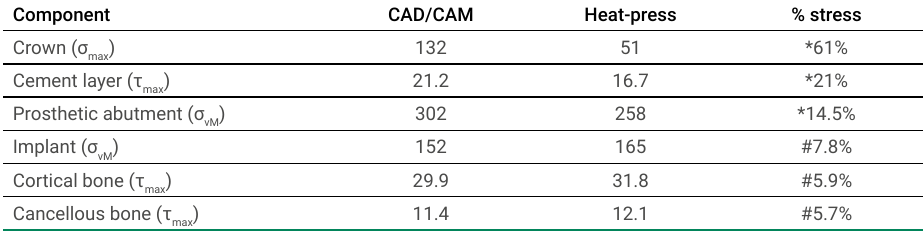
Table 2. Peak stress (MPa) and difference between groups after load. Component CAD/CAM